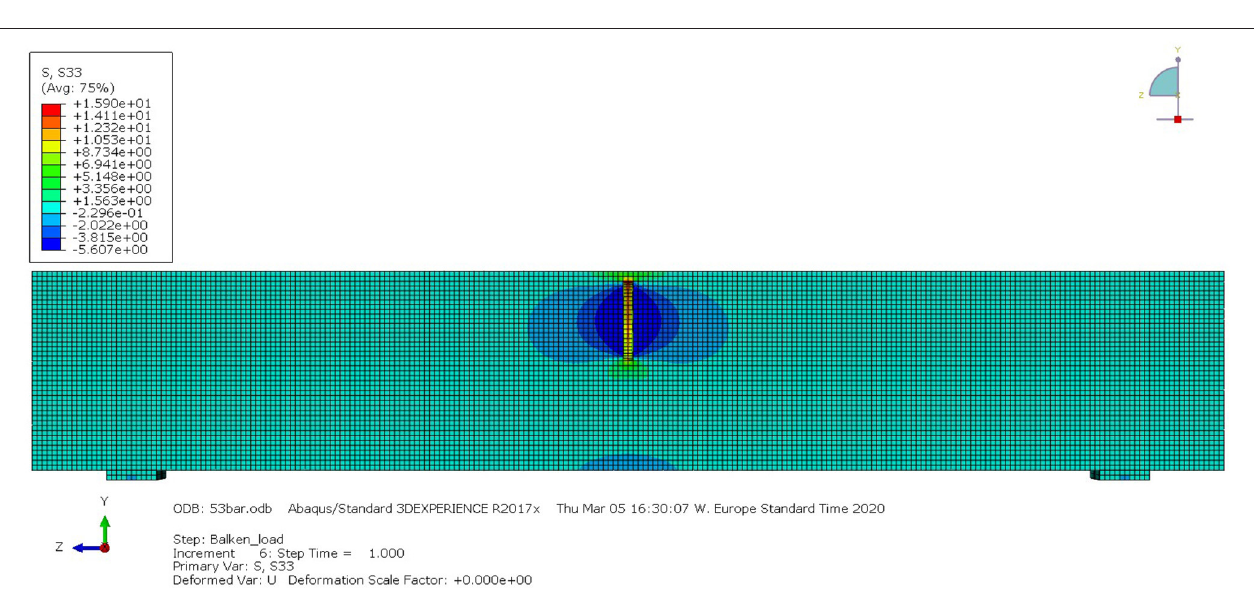
FIGURE 8 | Beam with one actuator to calculate the distance between the